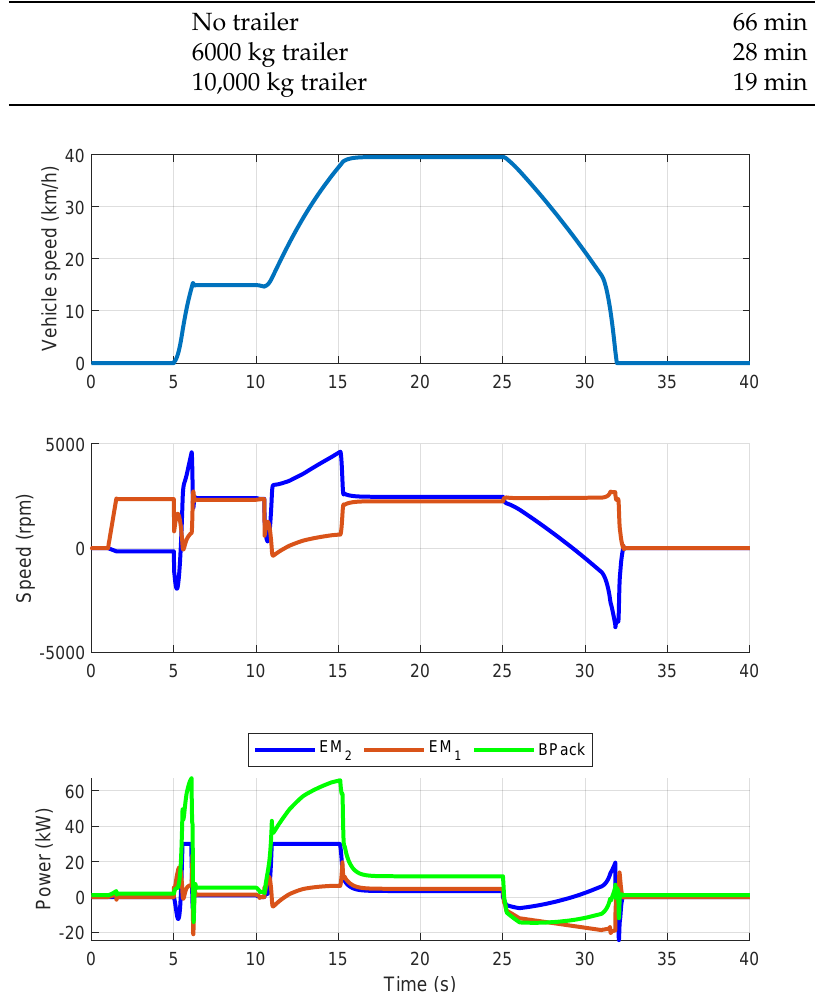
Figure 11. HeCVT 0–40 km/h acceleration test without trailer and 0% of slope in full electric